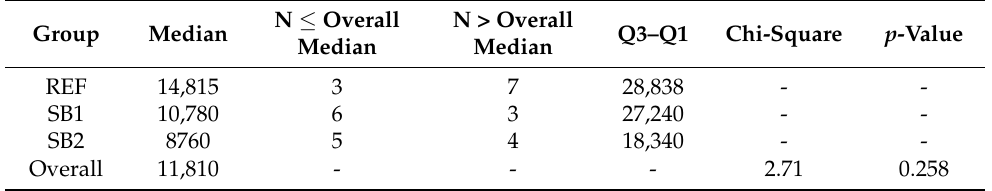
Table 3. Comparative evaluation of the three groups of asphalt mixtures using the Mood’s median test. Group